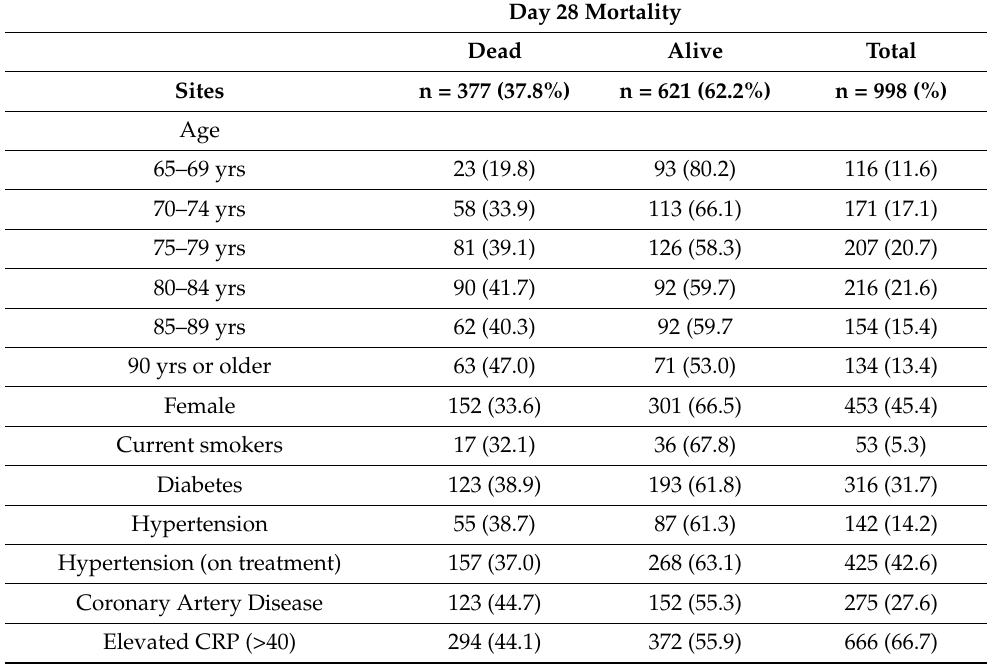
Table 1. Characteristics of the included patients in the primary